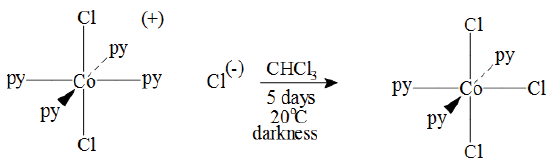
Figure 3. The trans -[Co(py)